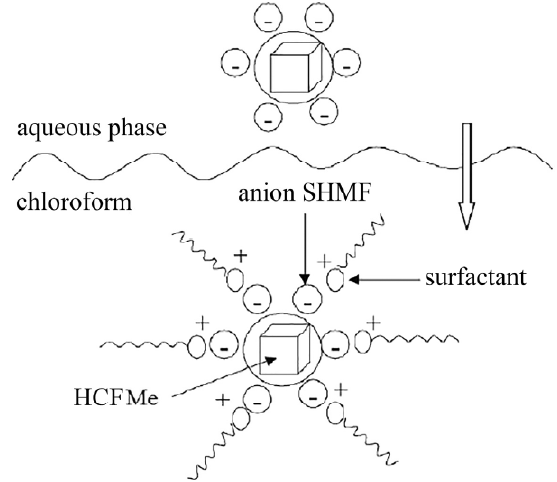
Fig. 1. Schematic representation of the extraction of metal HCF nanoparticles into the organic phase.